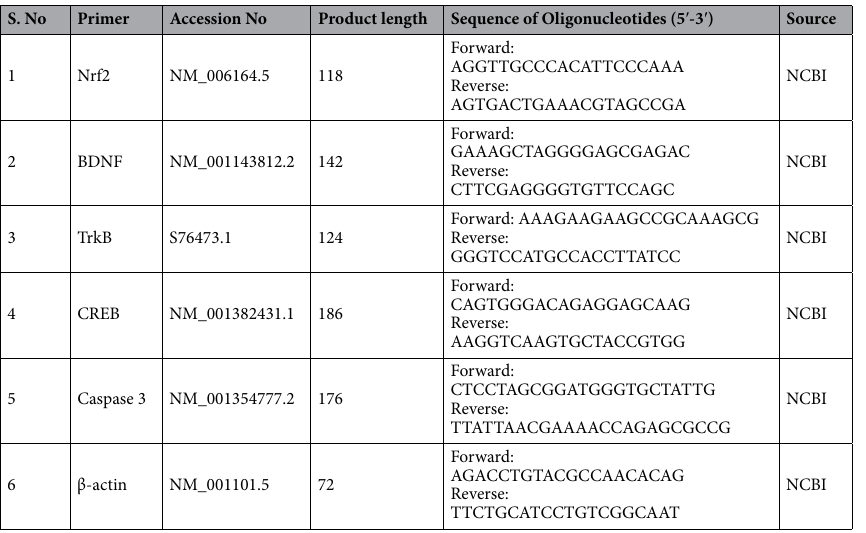
Table 1. The list of RT-qPCR primers and their